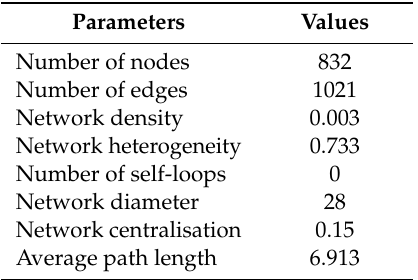
Figure 3. Node degree distribution of reconstructed metabolic network for acidosis ruminal epithelium. Table 6. General properties of the constructed